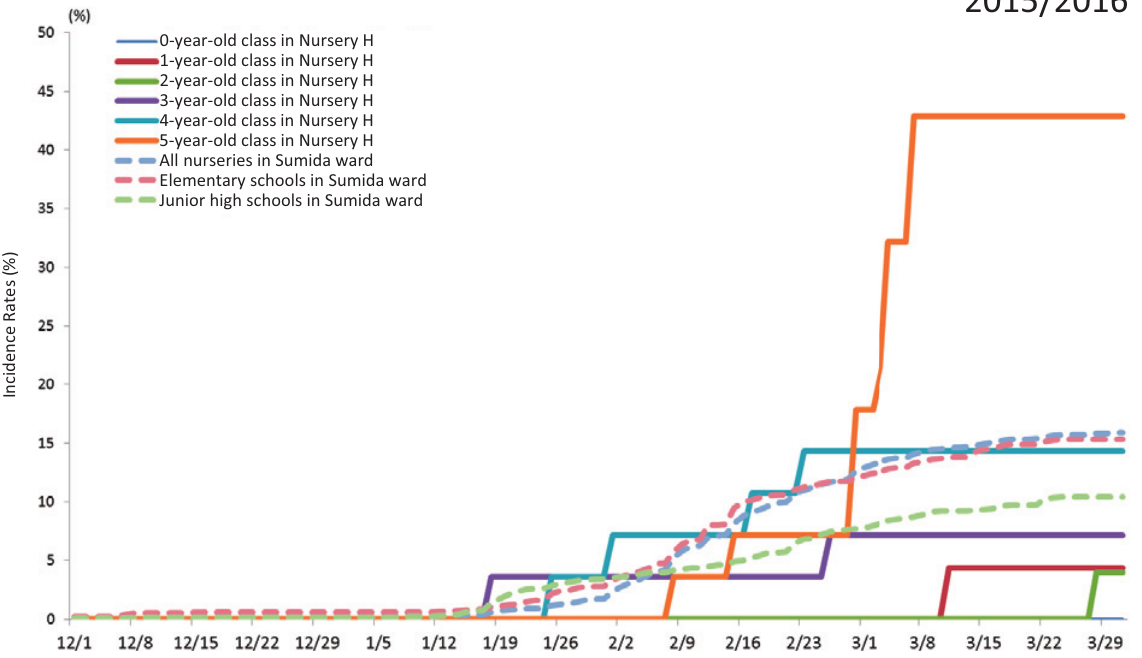
F i g . 4 D y namics of incidence rates of infl u enza b y a g e in N u rser y H compared w ith all n u rseries, and all elementar y and j u nior hi g h schools in S u mida W ard in the 2015/2016 season